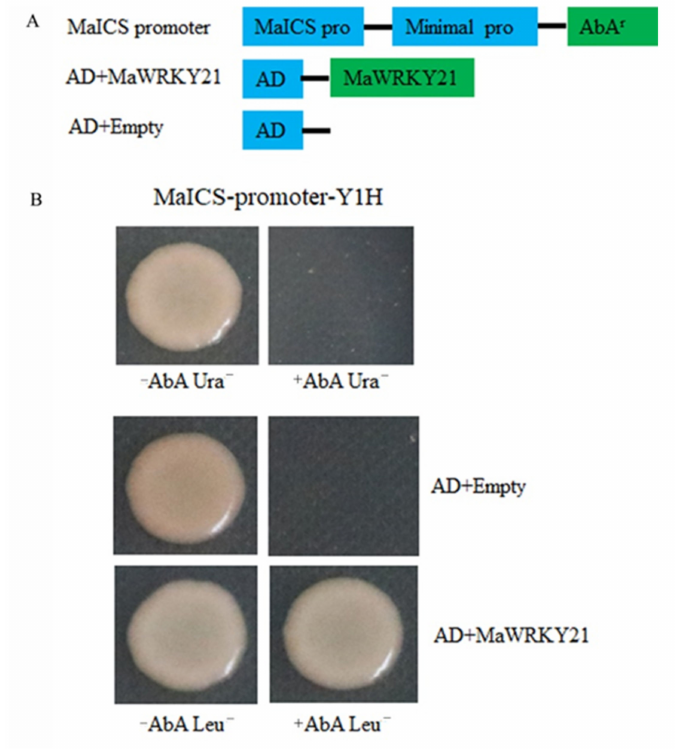
Figure 9. The interaction between MaWRKY21 and MaICS promoter by Y1H assay. ( A ) Schematic diagram vectors for Y1H assay. ( B ) Y1H